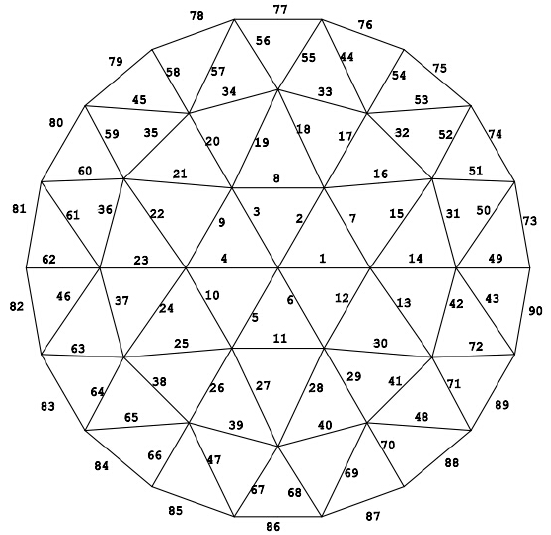
Figure 7. The codes of the elements.